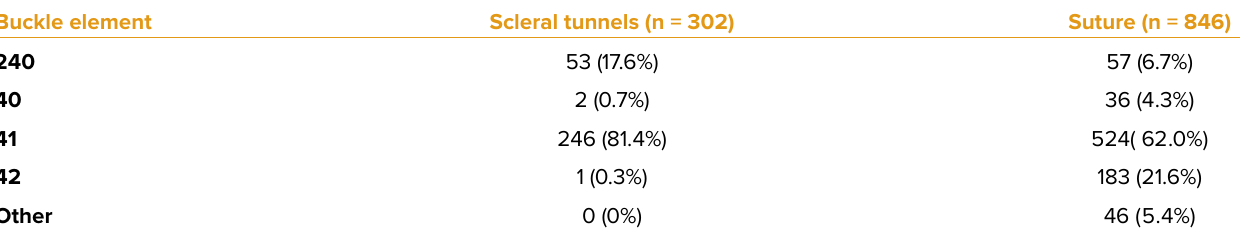
Table 2. Analysis of buckle type between the belt loop and scleral suture